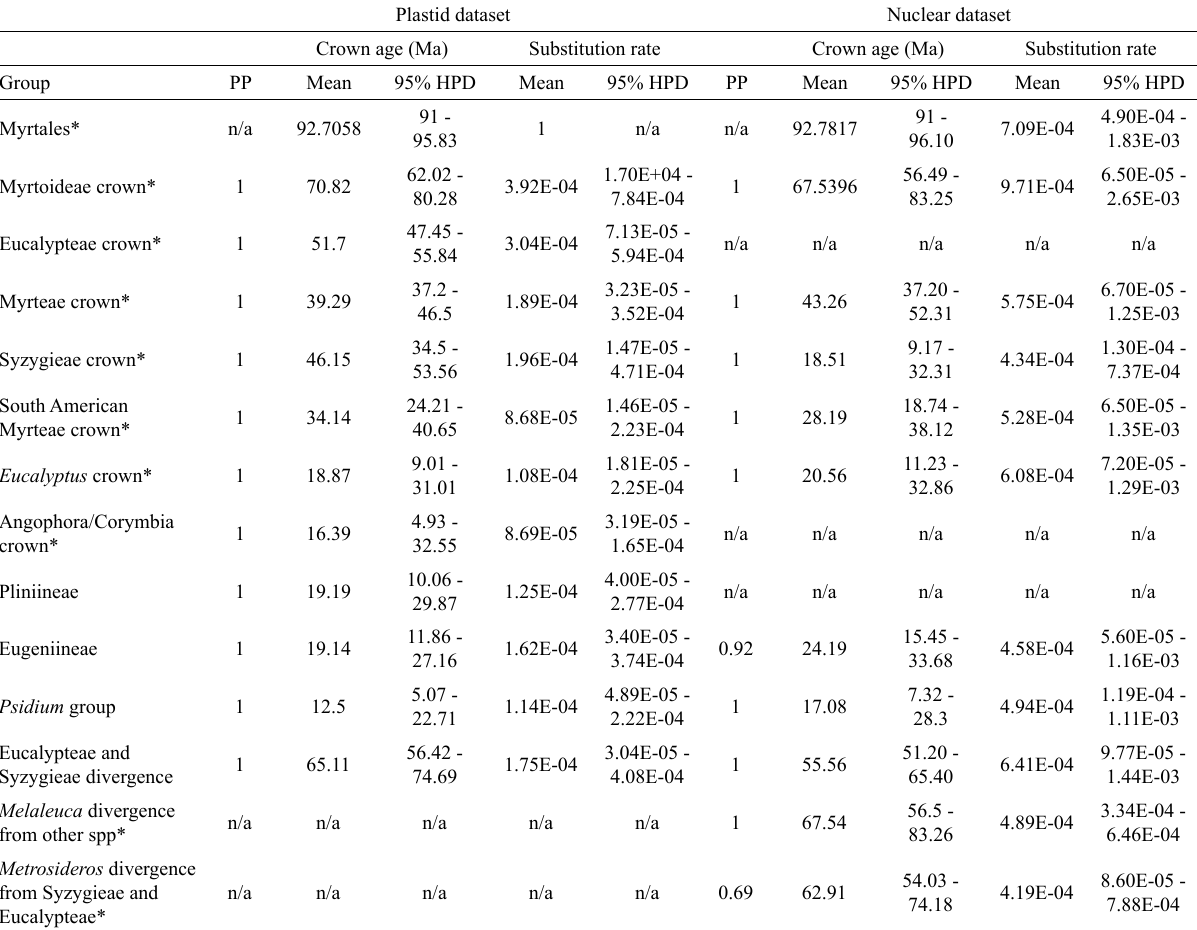
Table 2 – Estimates for species divergence times and substitution rates of the Bayesian analysis. Calibrated nodes are indicated by an asterisk